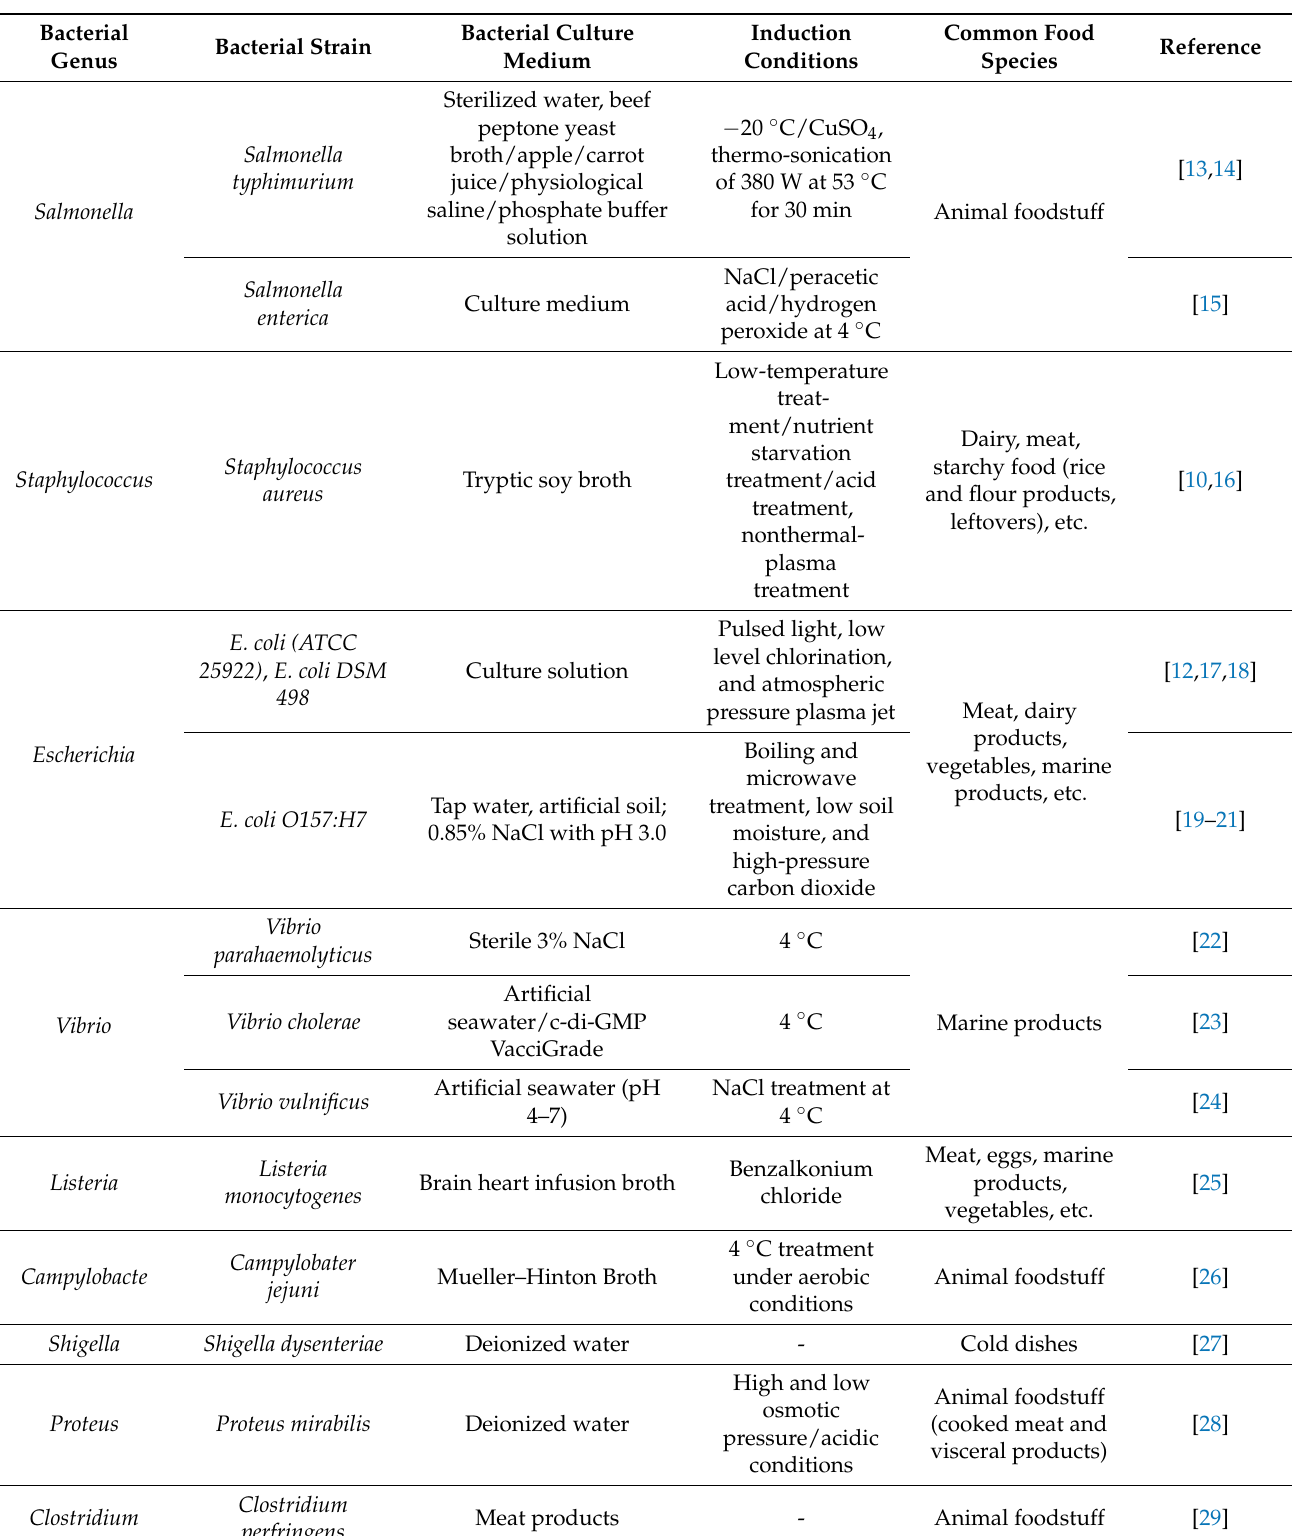
Table 1. Common foodborne pathogenic bacteria that can enter VBNC and their induction